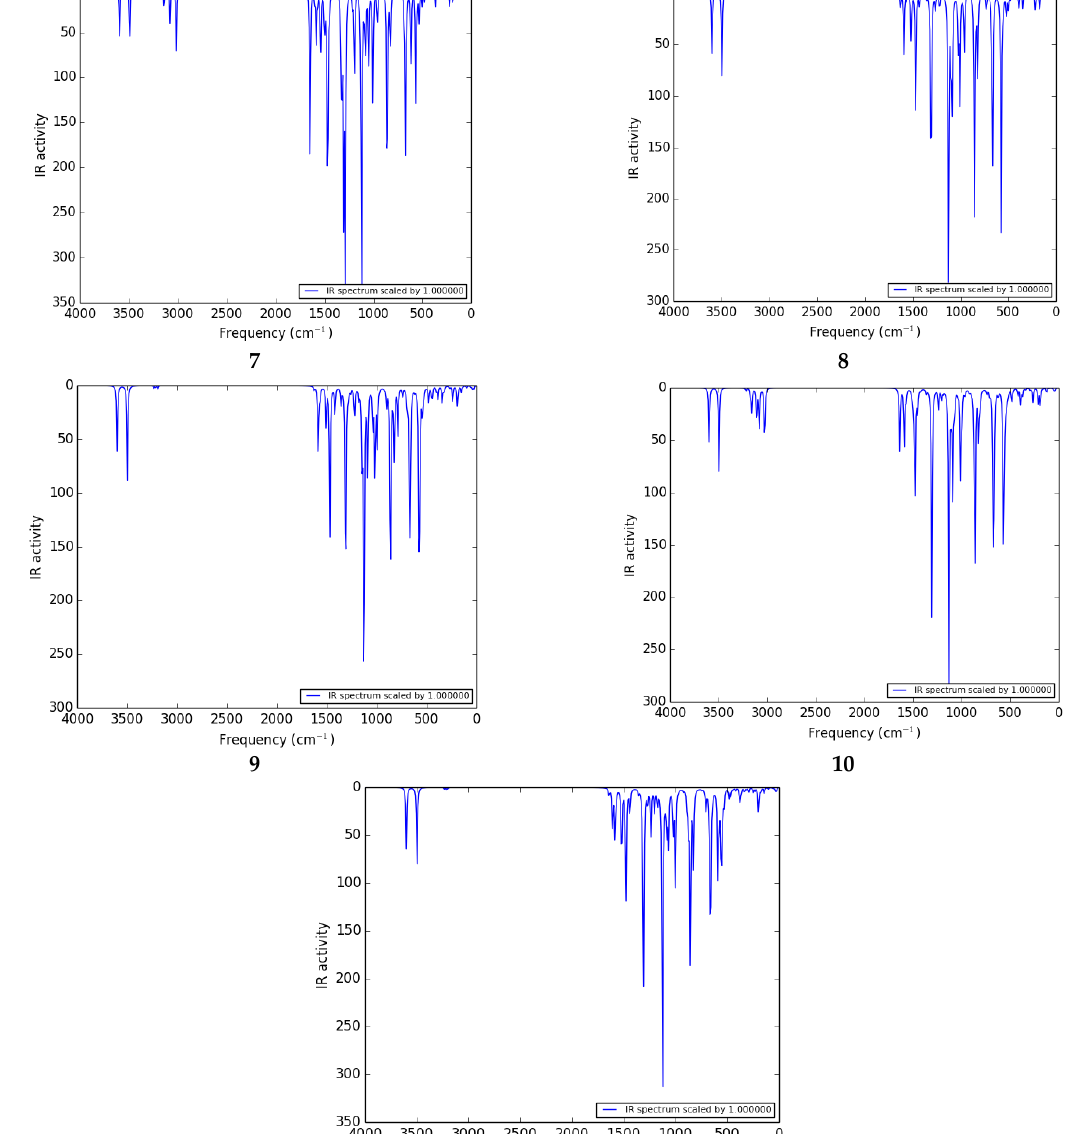
Figure 4. IR spectra of 1 to 11 calculated at the B3LYP/6-311G (d,p)/SMD 1,4-dioxane level of theory.